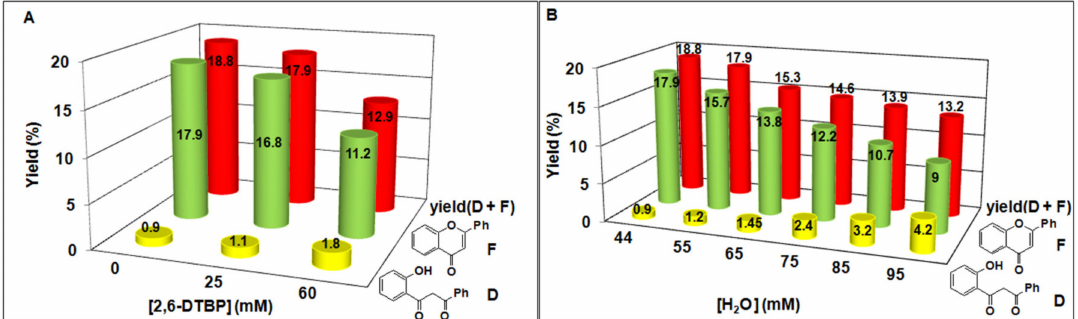
Figure 4. ( A ) Comparison of the product formation in the [Mn II (N4Py*)(CH 3 CN)] 2+ ( 2 ) catalysed oxidation of flavanone with mCPBA as co-oxidant and 2,6-DTBP as a radical trapping agent. ( B ) Comparison of the product formation in the presence of added